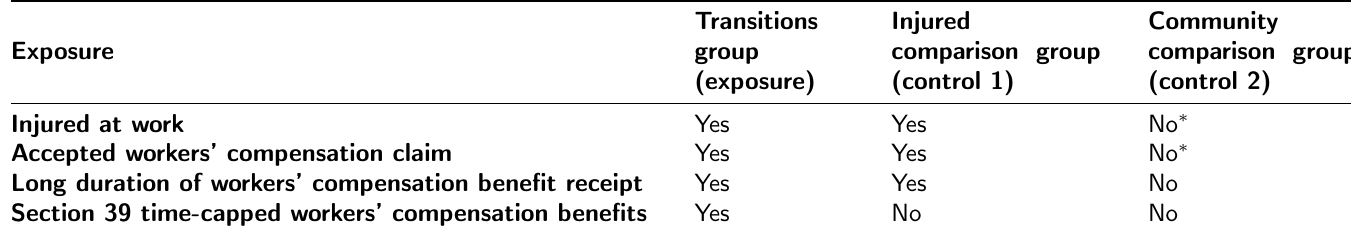
Table 1: Main exposures of interest by study